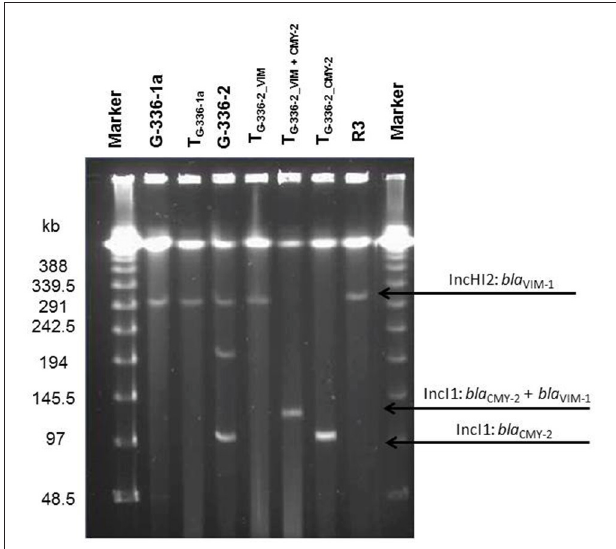
FIGURE 2 | Plasmid content of donor strains and transformants (S1-PFGE). Information about respective replicon types and the resistance gene localization derived from the whole genome data analysis. WT, wildtype; T, transformed E. coli NEB10 ®